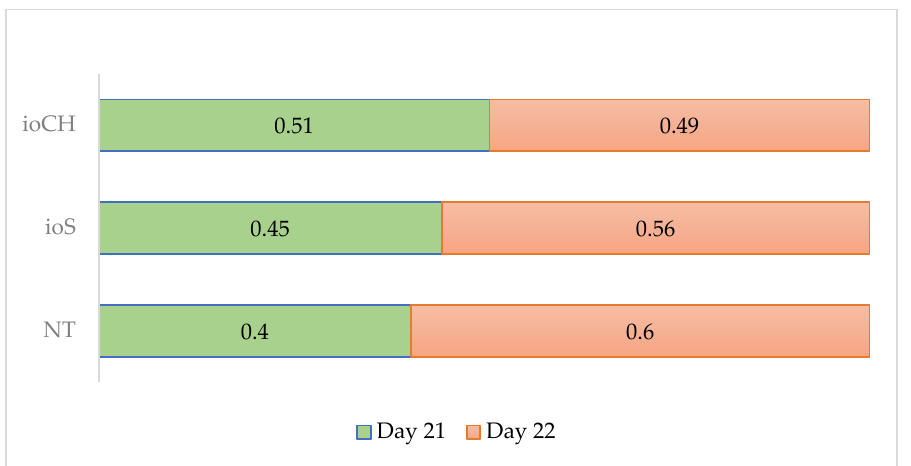
Figure 3. Ratios of hatched eggs per treatment on day 21 and 22: NT, control group; ioS, in ovo saline (NaCl); ioCH, in ovo carbohydrate solution.